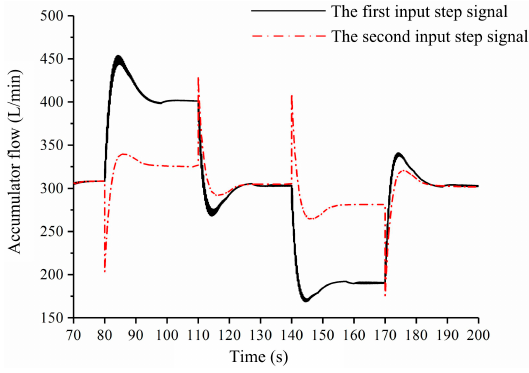
Figure 20. The energy storage flow curve.